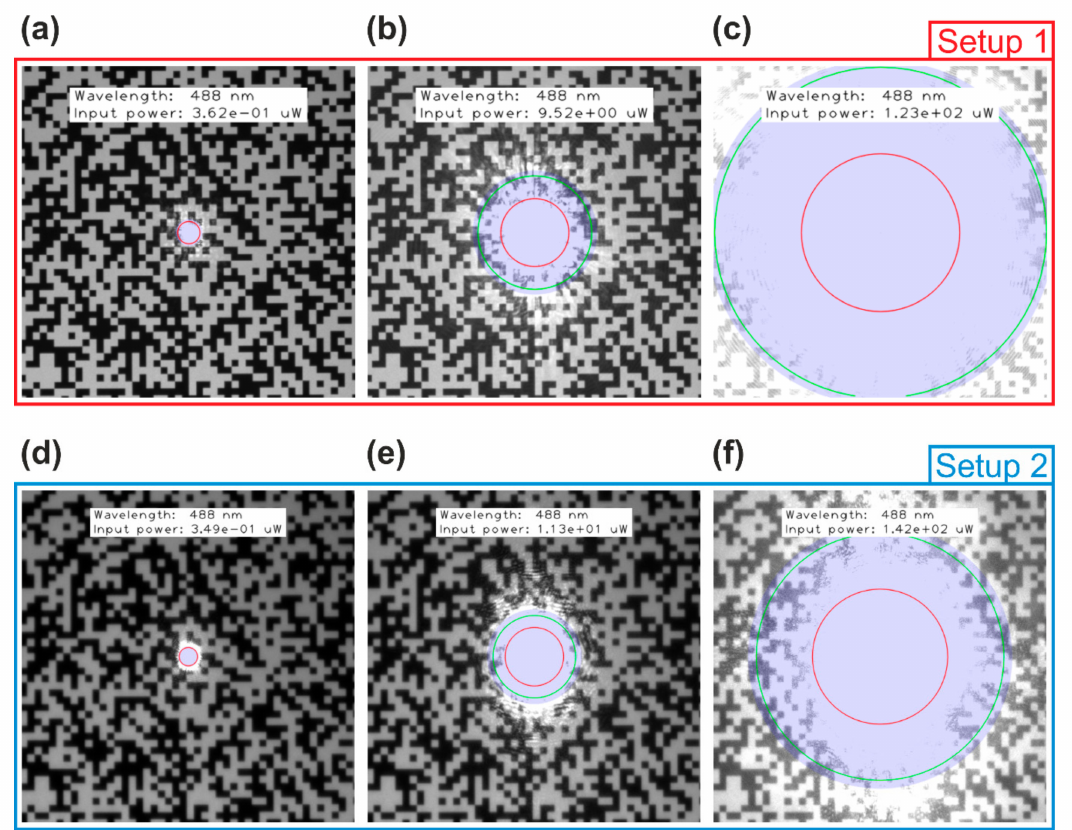
Figure 12. Laser dazzle spots recorded with two monochrome CMOS camera for a laser wavelength of 488 nm: ( a – c ): VR magic VRmC-12 / BW Pro and ( d – f ) Allied Vision Mako G-158B. Additionally, calculated spot sizes are drawn into the camera images: Red circle: spot size for di ff raction only, green circle: spot size for scatter only, blue disk: spot size taking di ff raction and scatter into